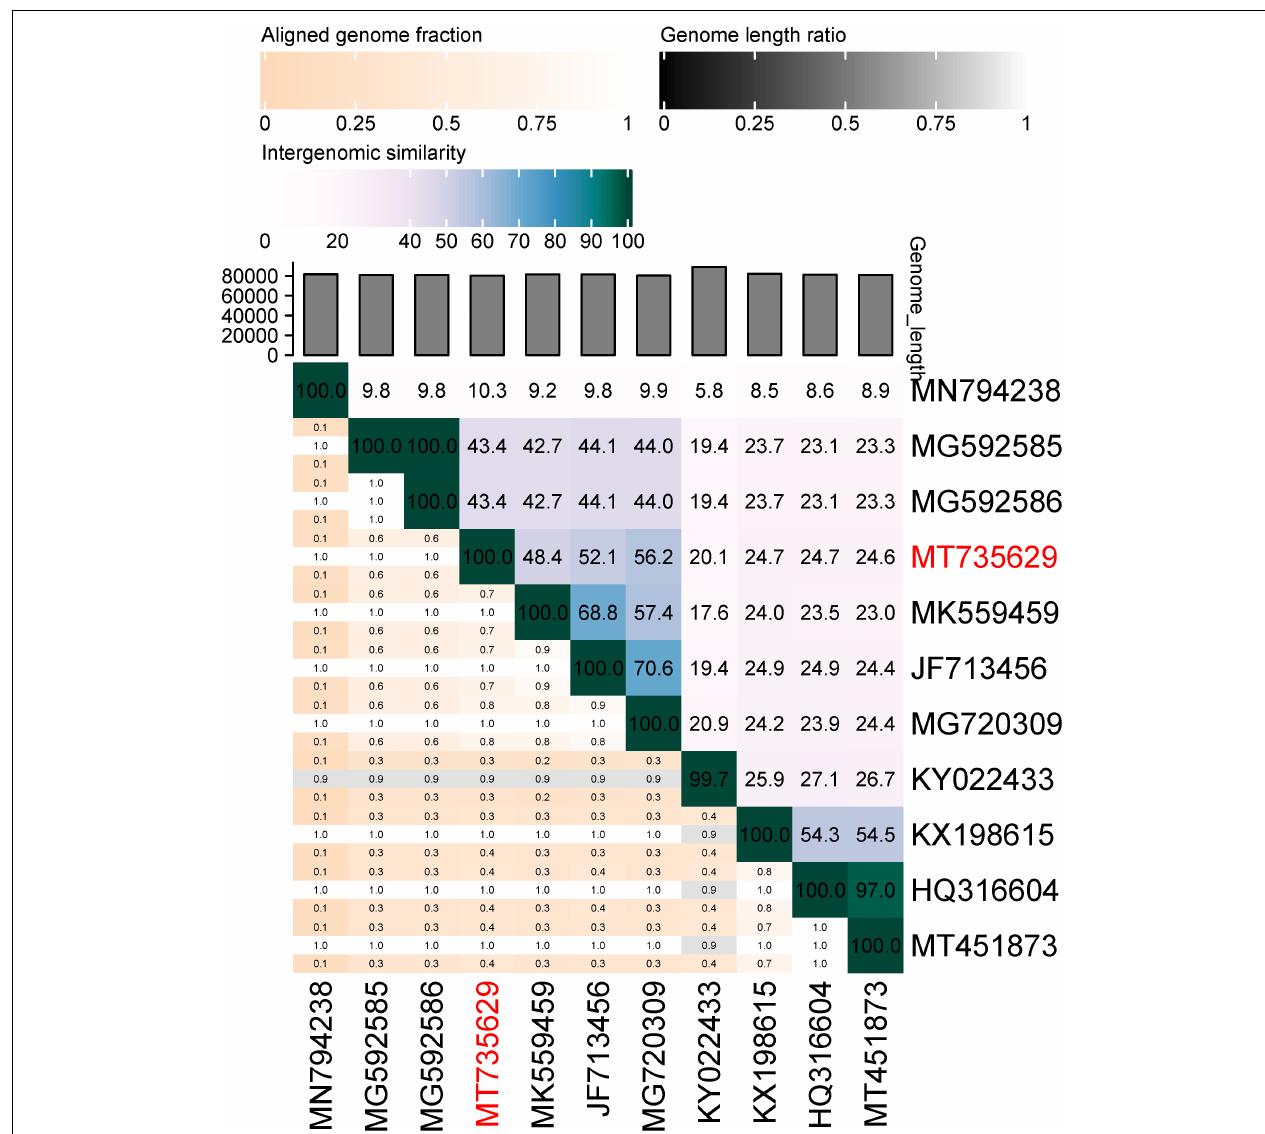
FIGURE 5 | Percentage sequence similarity between phages calculated using VIDIRIC. The horizontal and vertical coordinates indicate the corresponding phage Genebank number, and the phage in this study is marked in red font.